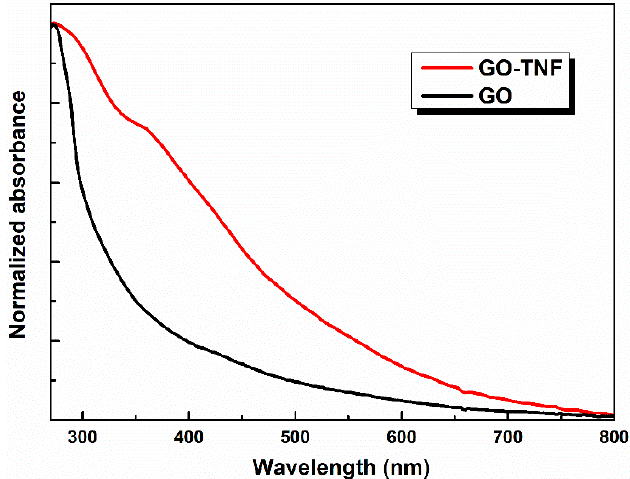
Figure 4. UV-vis spectra of GO (black line) and GO-TNF (red line).